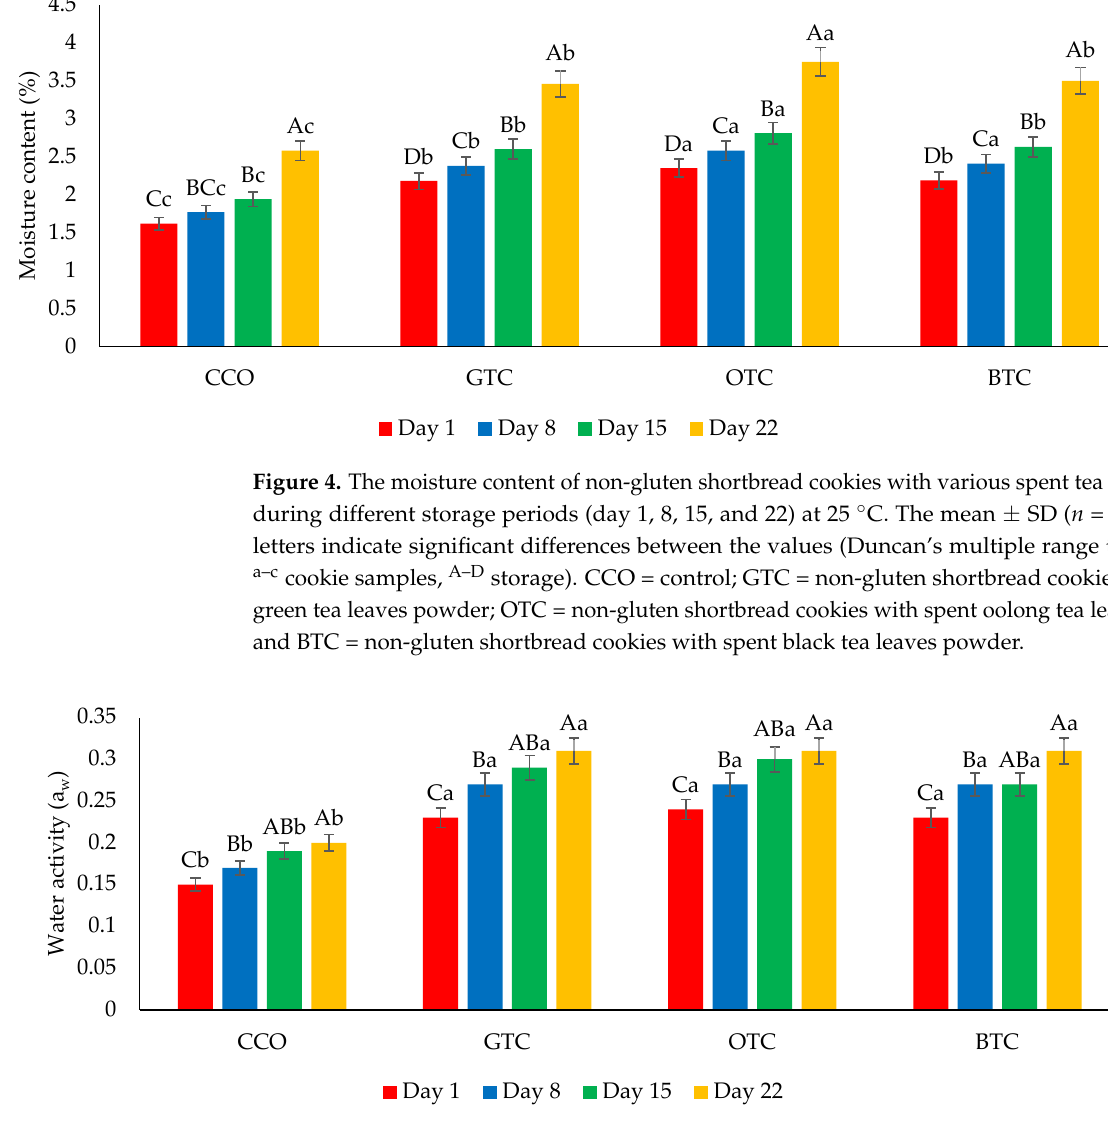
Figure 6. The hardness of non-gluten shortbread cookies with various spent tea leaf powders during di ff erent storage periods (day 1, 8, 15, and 22) at 25 °C. The mean ± SD ( n = 3). Di ff erent le tt ers indicate signi fi cant di ff erences between the values (Duncan’s multiple range test, p < 0.05, a,b cookie samples, A–D storage). CCO = control; GTC = non-gluten shortbread cookies with spent green tea leaves powder; OTC = non-gluten shortbread cookies with spent oolong tea leaves powder; and BTC = non-gluten shortbread cookies with spent black tea leaves powder.